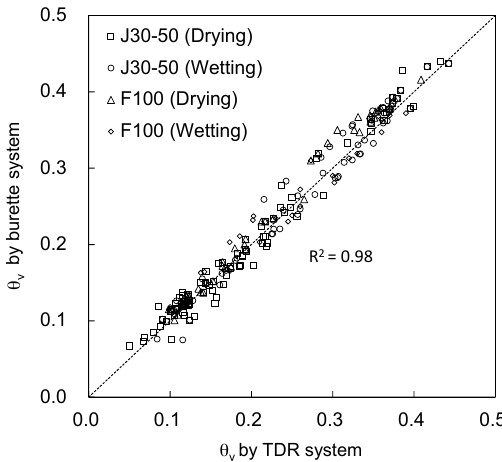
Figure 8. Volumetric water content comparison.